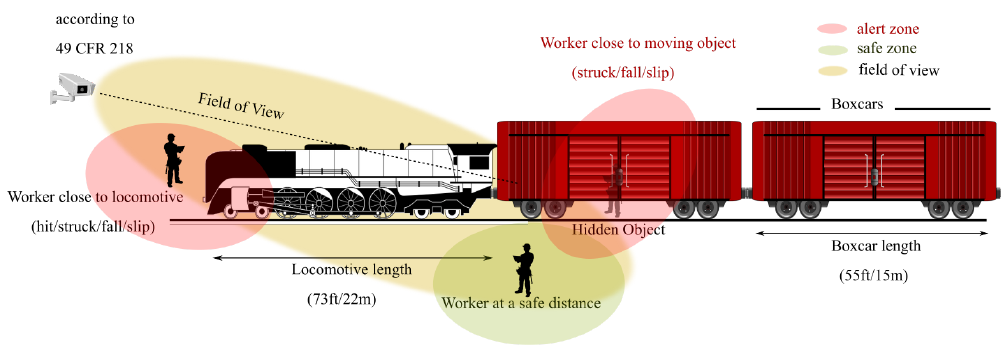
Figure 1. Scenario illustrating some of the